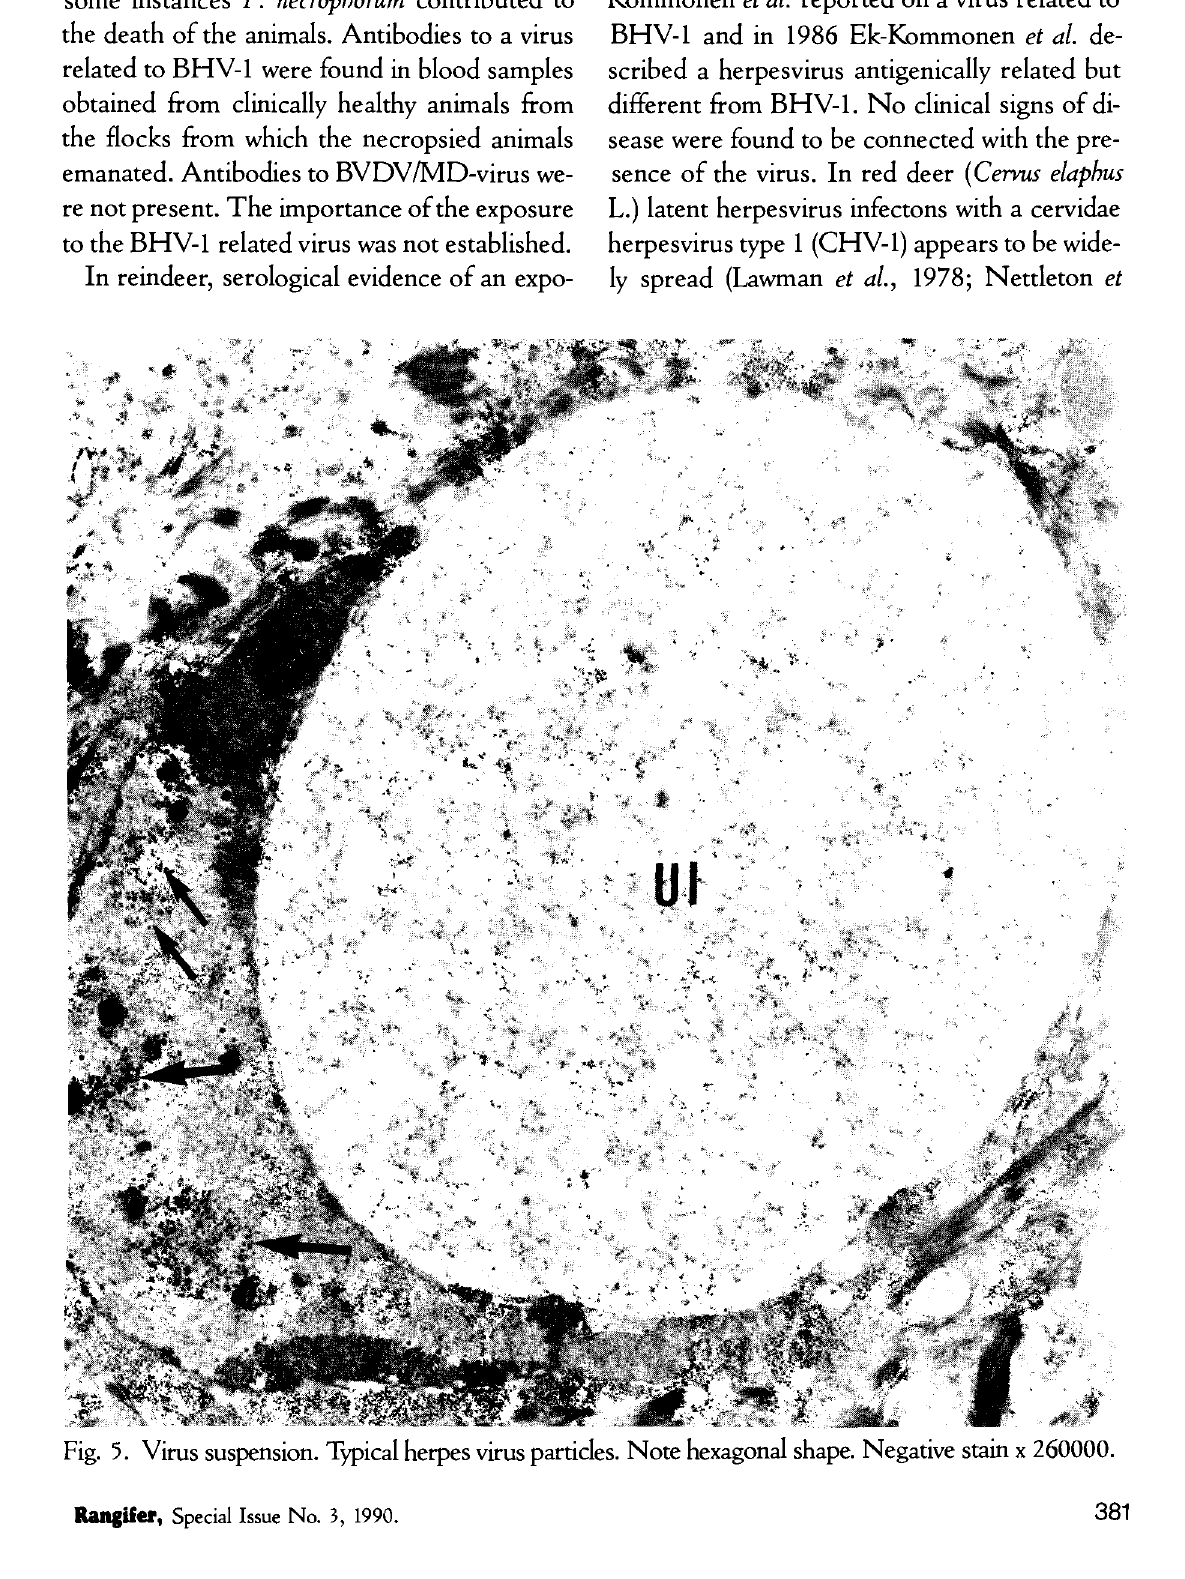
Fig. 5. Virus suspension. Typical herpes virus particles. Note hexagonal shape. Negative stain x 260000. Rangifer, Special Issue No. 3,